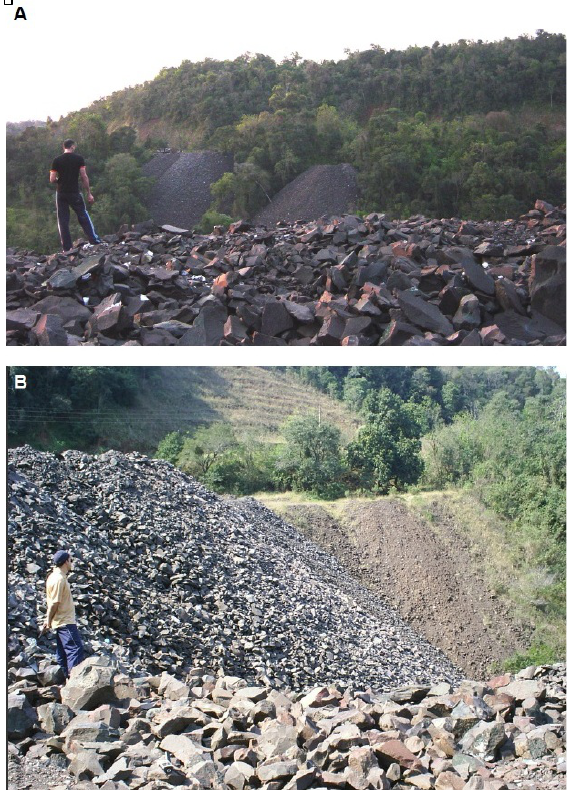
Figura 3. Photographs of amethyst mining